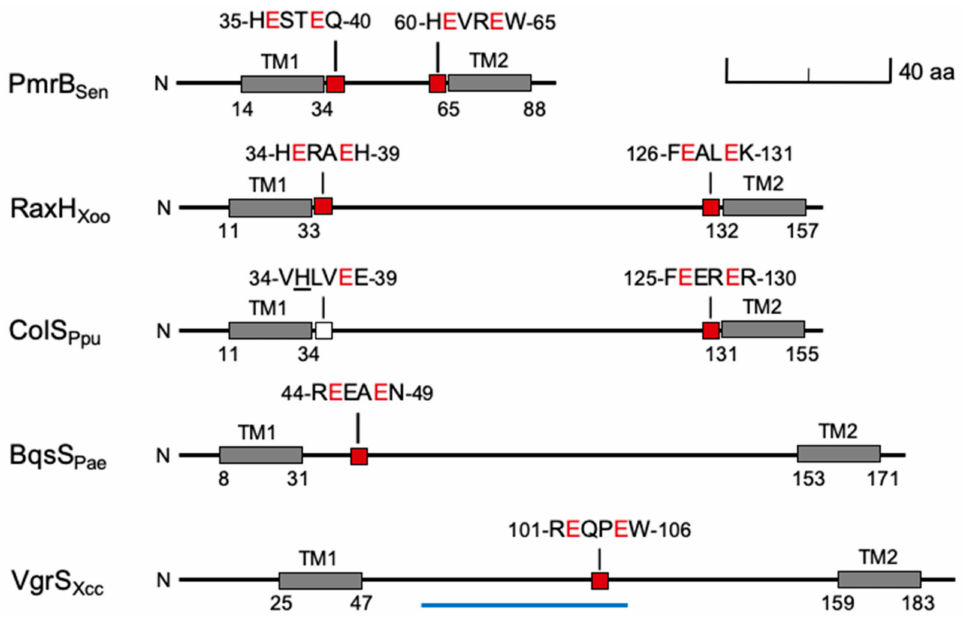
Figure 2. Periplasmic domain schematic structures for selected sensor proteins. Drawn to scale. The amino-terminal sequences are illustrated through the second of two transmembrane (TM) helices, shown as gray filled boxes. Numbers show positions of specific residues. The conserved ExxE motifs are shown as red-filled boxes, with the corresponding sequences above. The variant HxxE motif in ColS is shown as a white box. The blue line under the Xcc VgrS periplasmic domain shows the extent of a conserved sequence substitution in the Xoo sequence that removes the ExxE motif. Sen, Salmonella enterica LT2, Xoo, Xanthomonas oryzae pv. oryzae PXO99 A , Ppu, Pseudomonas pudita KT2440, Pae, Pseudomonas aeruginosa PAO1, Xcc, Xanthomonas campestris pv. campestris 8004. See text for